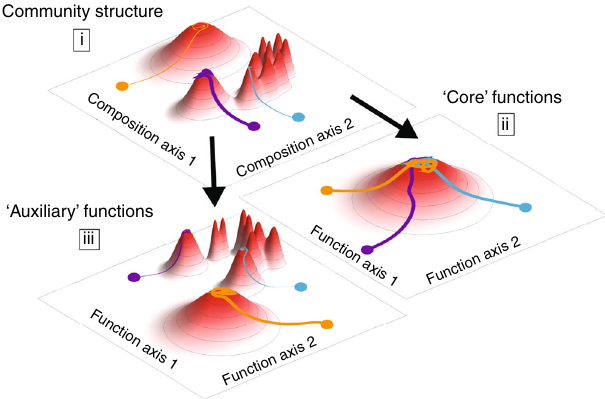
Fig. 5 Functional convergence depends on the type of function. Microcosms with the same environmental conditions assemble communities with distinct equilibria due to historical contingencies (i). Core functions such as respiration converge in a common environment, in agreement with the common notion that function and taxonomy are decoupled (ii). However, our results show key functional differences in ‘ auxiliary ’ metabolic functions, such as chitinase activity or carbon source preference, are strongly coupled to community composition